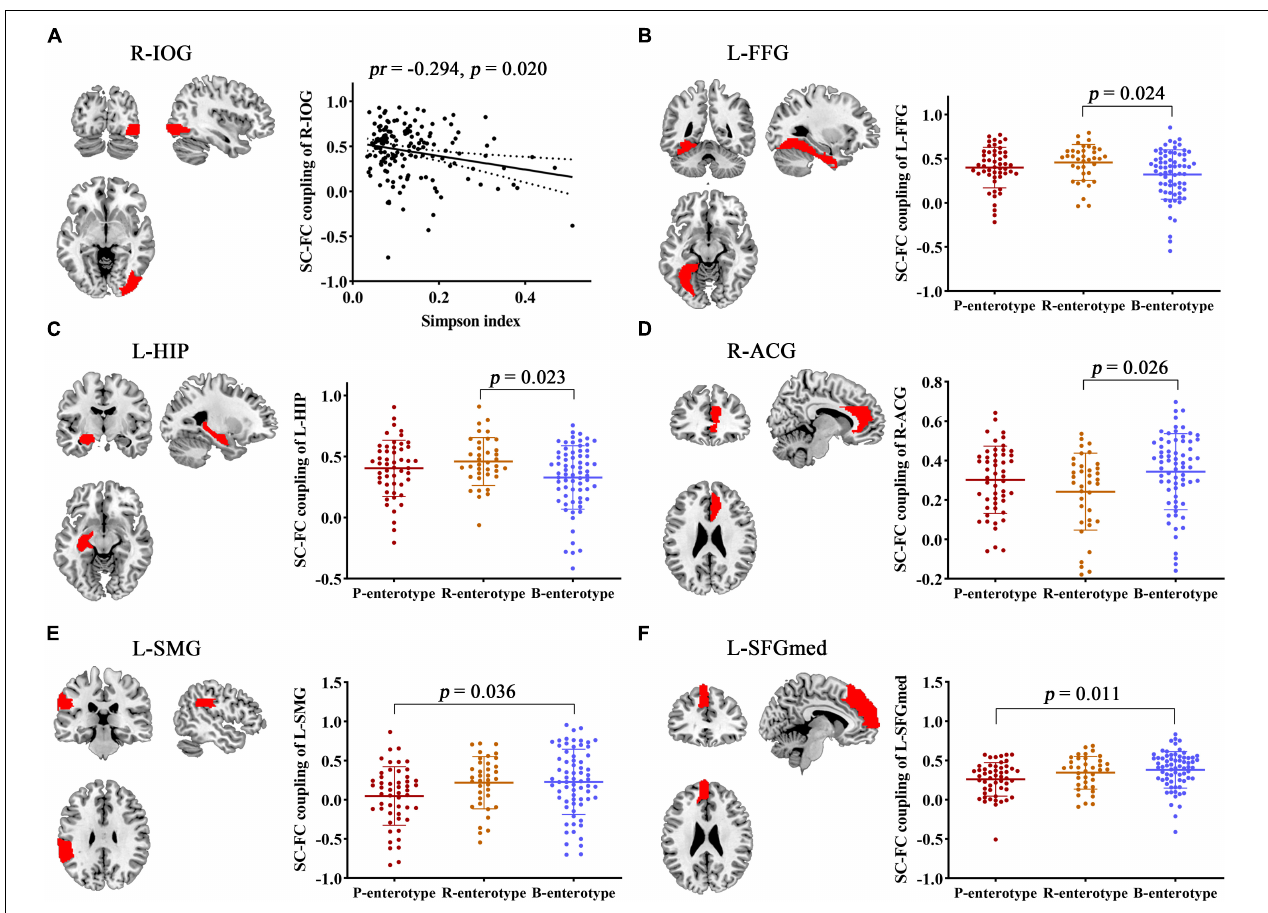
FIGURE 8 | Correlation and inter-group comparisons between SC–FC coupling, gut microbial diversity, and enterotypes. Spatial maps show the significantly related or different brain regions. (A) Scatter plots of the correlations between gut microbial diversity and SC–FC coupling. (B–F) Inter-group comparisons in SC–FC coupling across enterotypes. ACG, anterior cingulate and paracingulate gyri; FC, functional connectivity; FFG, fusiform gyrus; HIP, hippocampus; IOG, inferior occipital gyrus; L, left; pr , partial correlation coefficient; R, right; SC, structural connectivity; SMG, supramarginal gyrus; SFGmed, medial superior frontal